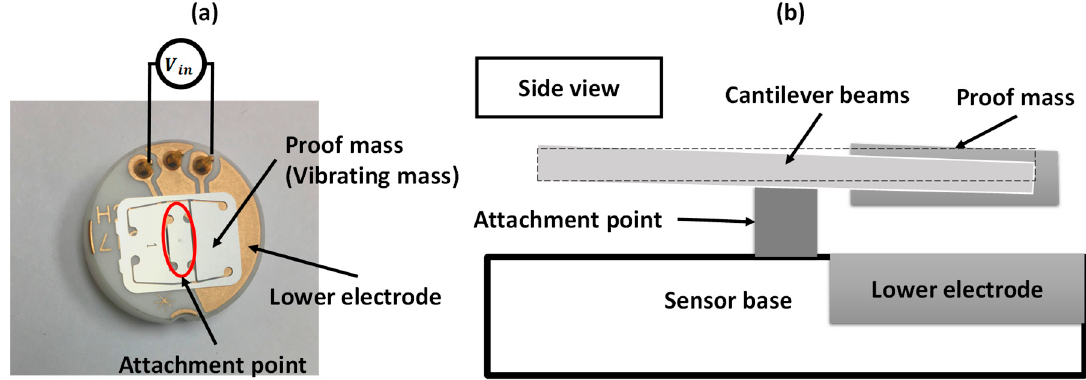
Figure 1. The device used in this study. ( a ) A picture top view. ( b ) A schematic of the side view.